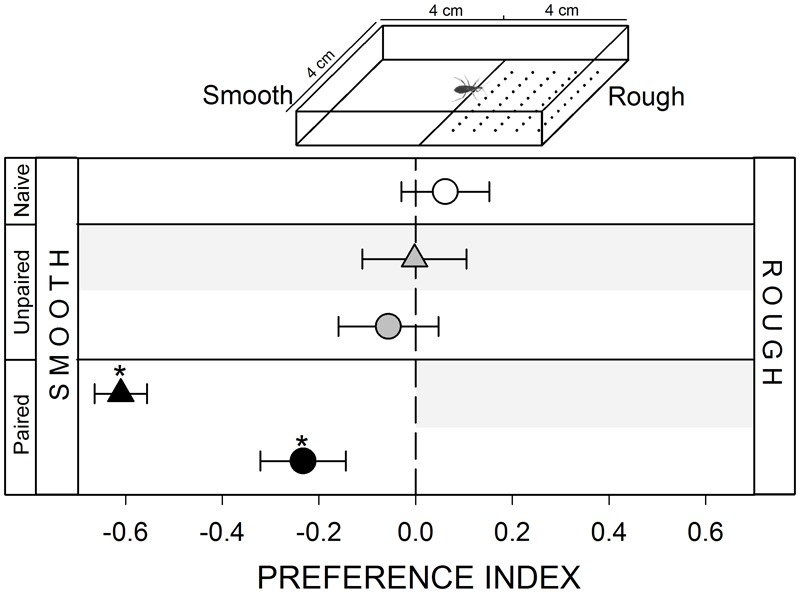
Responses of Rhodnius prolixus to a mechanical stimulus. No innate response was registered when insects were confronted to a smooth/rough substrate choice (white circle, p > 0.05). Unpaired yoke controls presented the same pattern: i.e., no preference (gray triangle and circle, p > 0.05 in both cases). During training, insects avoided the punished zone: i.e., the rough side (black triangle, p < 0.05). During test the smooth side was still preferred (black circle, p < 0.05) evincing an experience-dependent behavioral plasticity. Each point represents the mean (±SE) spatial preference of 30 insects individually released in a 2-choice rectangular walking arena. Asterisks denote statistical differences between the PI and the value 0 (p < 0.05) evinced by One sample T-test. Gray shadows show the zone in which punishment was delivered during unpaired and paired trainings.